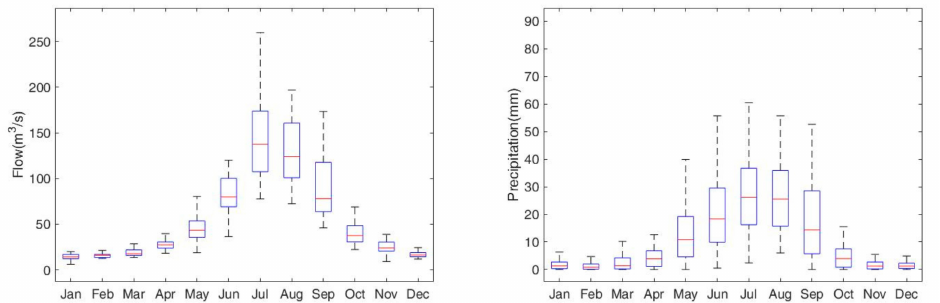
Figure 2. Analysis of stochasticity of flow and